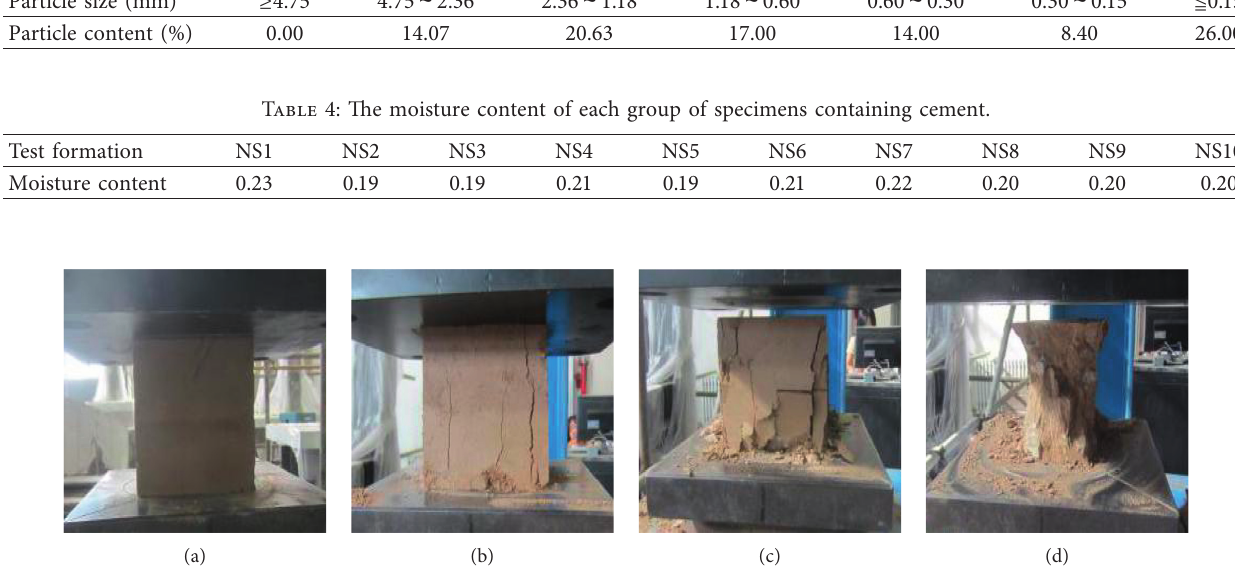
Figure 3: Compressive strength tests of raw soil material cubes. Loading (a), cracking (b), damage (c), and completely destroyed (d). Table 5: Test results of compressive strength of specimens mixed with cement, gravel, and raw